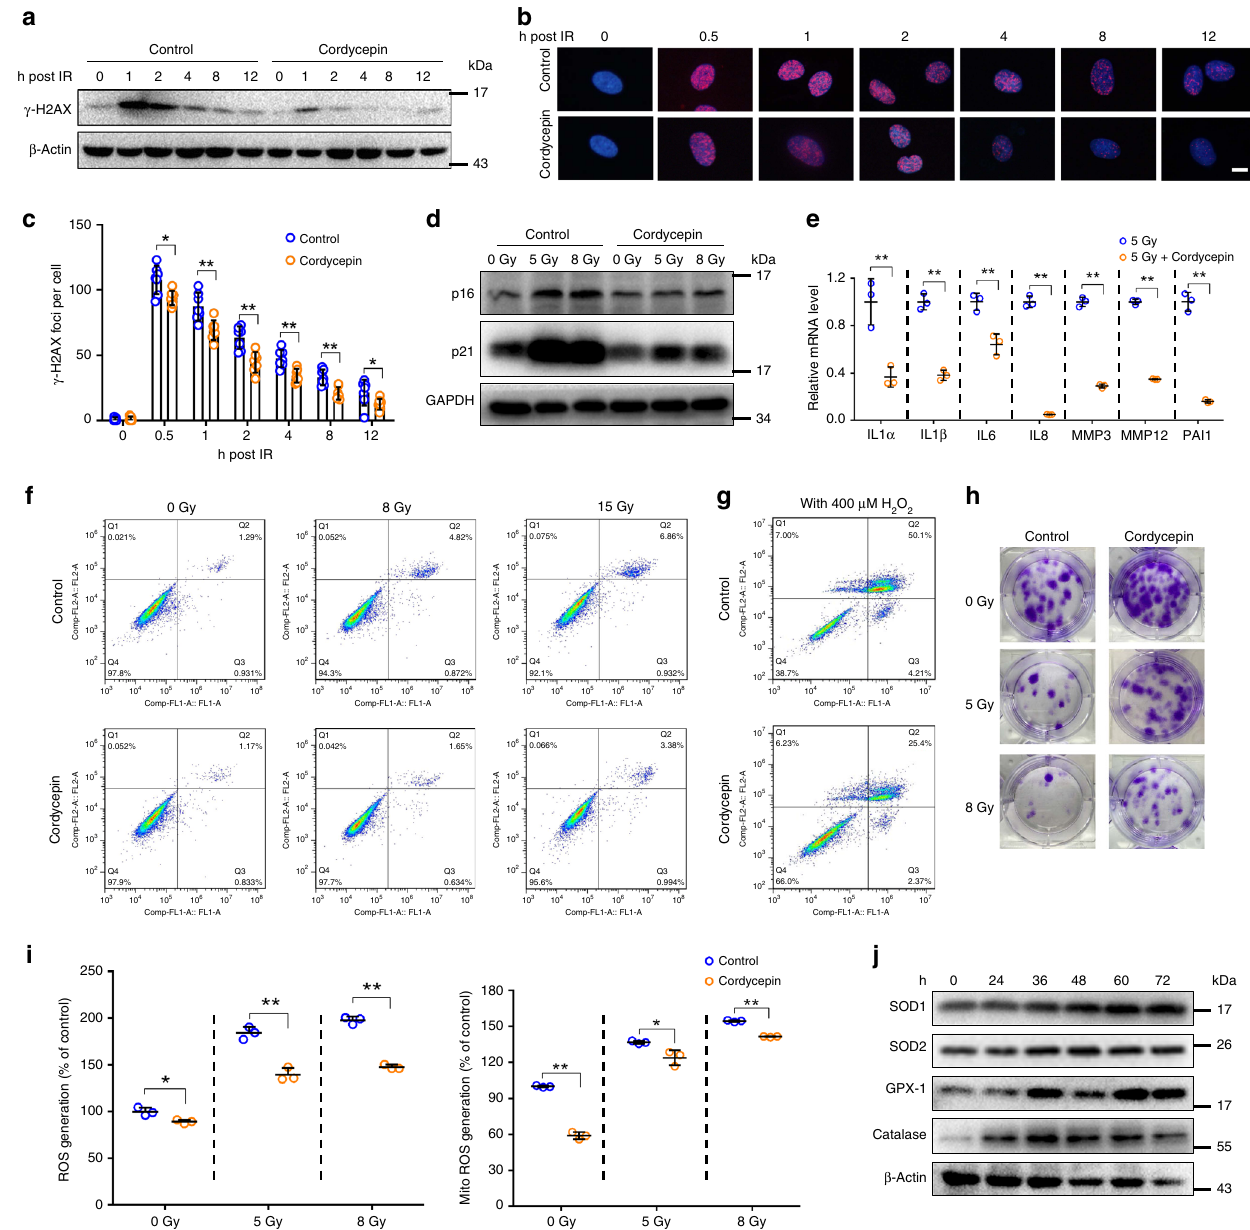
Fig. 2 Cordycepin decreases cell senescence and SASP in vitro. a Western blot analysis of γ -H2AX expression in fi broblasts after 5 Gy radiation. b Representative images of nuclei γ -H2AX in fi broblasts 0 – 12 h after 5 Gy radiation. This test was repeated three times. Representative images were shown. c Average number of γ -H2AX per nucleus 0 – 12 h after 5 Gy radiation ( n = 7). d Western blot analysis of p16 and p21 levels in irradiated control or cordycepin-treated fi broblasts 7 days after radiation. This test was repeated three times. Representative images were shown. e Quanti fi cation of mRNA expression for senescence secretory phenotype in irradiated control or cordycepin-treated fi broblasts 7 days after radiation ( n = 3). f Fibroblasts were treated with cordycepin for 72 h and harvested for detection of apoptosis using fl ow cytometry 24 h following exposure to radiation. g Fibroblasts were treated with cordycepin for 72 h and harvested for detection of apoptosis using fl ow cytometry 12 h following H 2 O 2 treatment. h Representative images of fi broblasts colonies generated in survival assays following 0/5/8 Gy radiation. i Analysis of reactive oxygen species (ROS) levels and mitochondrial superoxide by H2DCF-DA or MitoSOX Red staining 24 h after radiation in fi broblasts pretreated or not (control) with cordycepin ( n = 3). j SOD1, SOD2, GPX-1, and Catalase expression levels in whole cell lysates from cordycepin-treated fi broblasts for the indicated times. Bars represent 10 μ m ( b ). Data in c , e , and i represent the means± S.D. (* P < 0.05, ** P < 0.01; student ’ s t